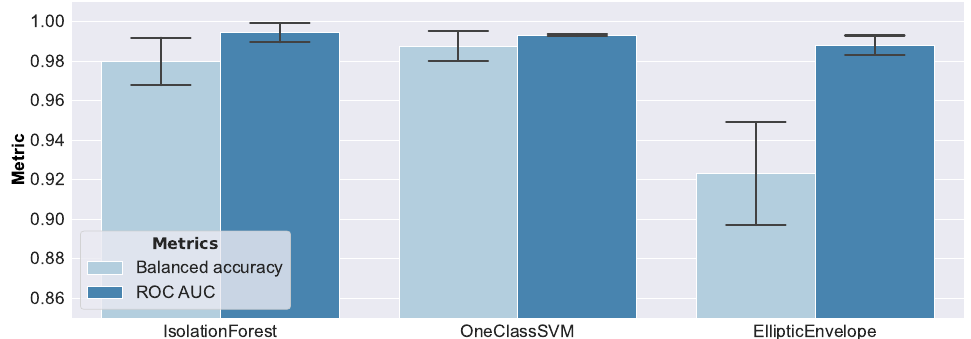
Figure 13. Anomaly detection results on synthetic data, by different ML models. According to balanced accuracy, the Isolation Forest and One-Class SVM seemed to perform reasonably well. The Elliptic Envelope exhibited the worst performance, due to a relatively high false positive